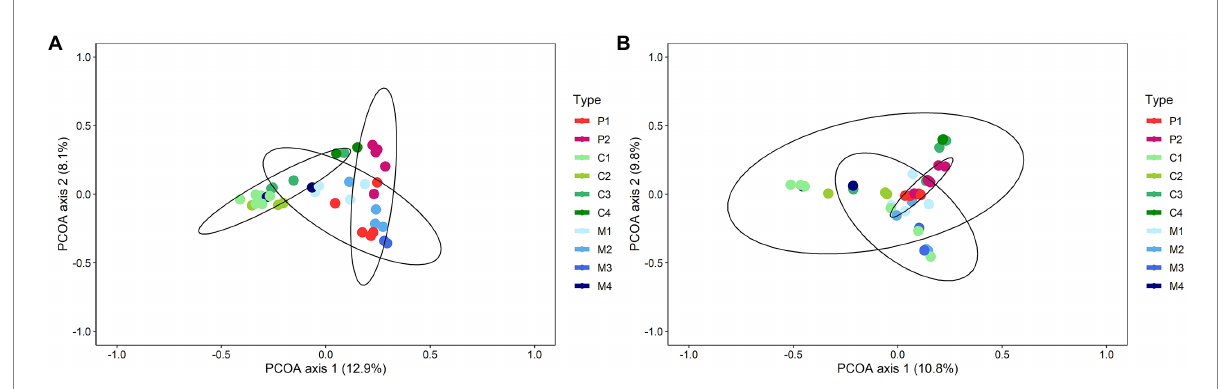
FIGURE 1 Shifts in bacterial (A) and fungal (B) community composition between the subtypes of peat-based substrates, composts, and management residues. Both figures represent Principal Coordinate Analysis (PCoA) profiles of pairwise community dissimilarity (Bray-Curtis) indices of either bacterial (16S V3-V4 rRNA gene) or fungal (ITS2 gene) sequencing data, respectively. Colors indicate the different subtypes of peat-based substrates, composts, and management residues. P1 = pure peat-based substrates ( n = 5); P2 = limed peat-based substrates ( n = 5); C1 = green composts ( n = 7); C2 = VFG composts ( n = 3); C3 = woody composts ( n = 4); C4 = peat composts ( n = 2); M1 = grass clippings ( n = 4); M2 = chopped heath ( n = 4); M3 = forest sods ( n = 2); M4 = woody fractions of composts ( n =